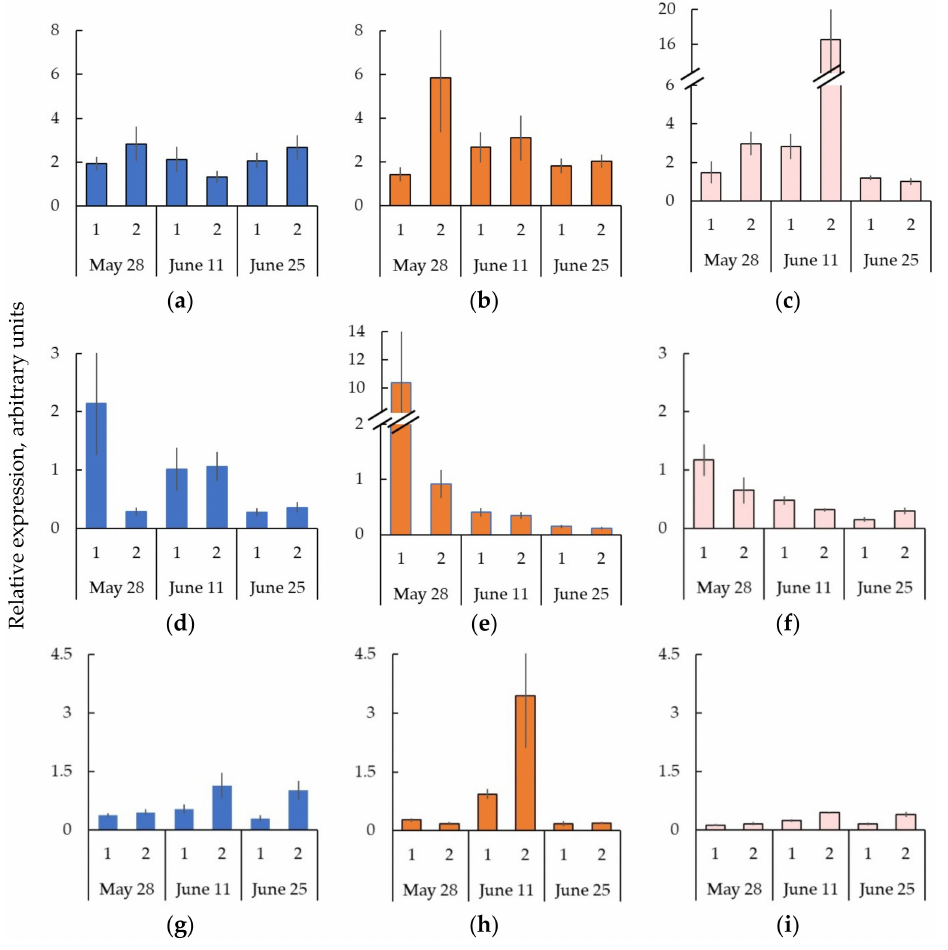
Figure 9. The relative expression (arbitrary units) of genes BpWOX4 ( a – c ), BpCLE41/44a ( d – f ), and BpPXY ( g – i ) in tissues including the cambial zone, differentiating phloem, and mature phloem (1) and differentiating xylem (2) B. pendula var. pendula ( a , d , g ), non-figured ( b , e , h ), and figured ( c , f , i ) B. pendula var. carelica trees. Samples were collected on 28 May, 11 June, and 26 June 2020. n = 9. The WOX4 homeodomain transcription factors are downstream targets of the TDIF/ CLE41-PXY/TDR signaling pathway [9,32]. We showed that the maximum expression of BpCLE41/44a in the Bp trees was in tissues sampled from the bark side on 28 May, and its value was 10 times higher than that from the xylem side (Figure 9d). Previously, J. Alonso- Serra et al. [31] found the TPM maximum for BpCLE41/44a in non-conductive secondary phloem, conductive phloem, and cambium ( Bpev01.c0016.g0065 , Table S2 after [31]). At the middle and end of June, the number of BpCLE41/44a transcripts did not differ between Fractions 1 and 2. On 11 June, the expression level of BpCLE41/44a was two times higher than on June 25 (Figure